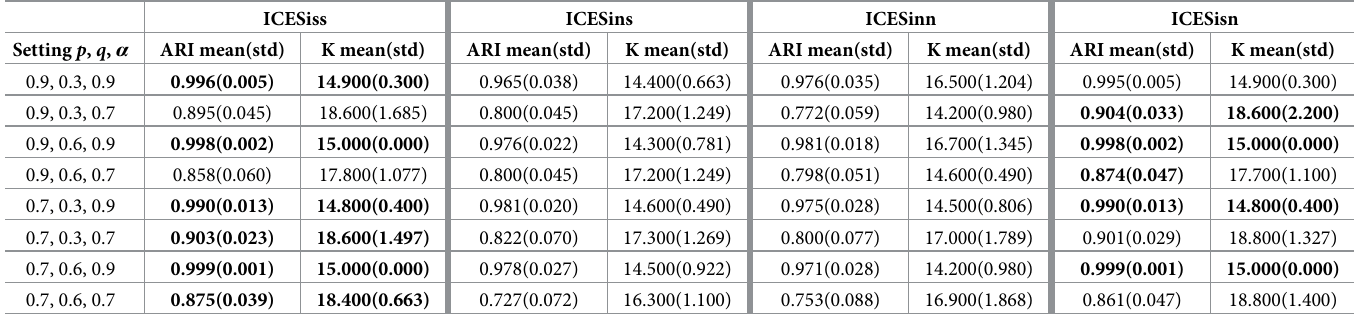
The best results are highlighted in bold-face.